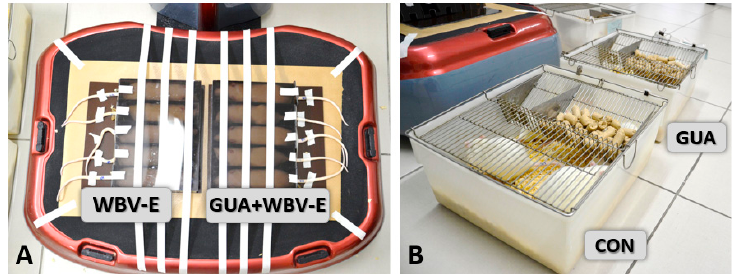
Figure 3. Rats from the groups WBV-E and GUA + WBV-E ( C and D ) are placed on the base of the vibrating platform (VP) turned on. At the same time, the groups CON and GUA ( A and B ) are put close (about 20 cm) to the VP.